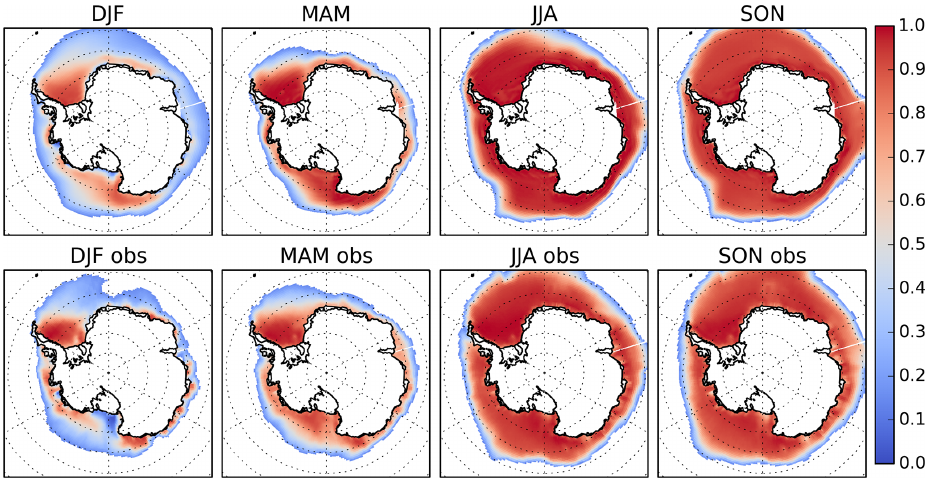
Figure 4. 2020–2030 ALL-EM (top) and HadISST1 (bottom) fractional sea ice concentration in each season. The extent is defined by a threshold 0.15 concentration. DJF: December–January–February, MAM: March–April–May, JJA: June–July–August, SON: September– October–November, obs: